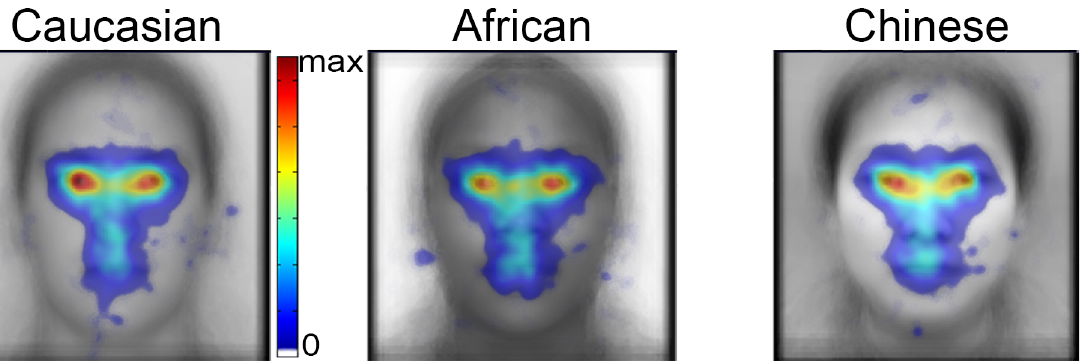
Fig 4. Spatial density of fixations for Caucasian, African, and Chinese faces during the study phase. The faces plotted beneath the spatial density plots are the average of all faces of the given race after alignment. Fixations are plotted as Gaussian densities summed across trials and participants. Fixation density is indicated using a color scale from zero to the maximum density value observed, with zero being